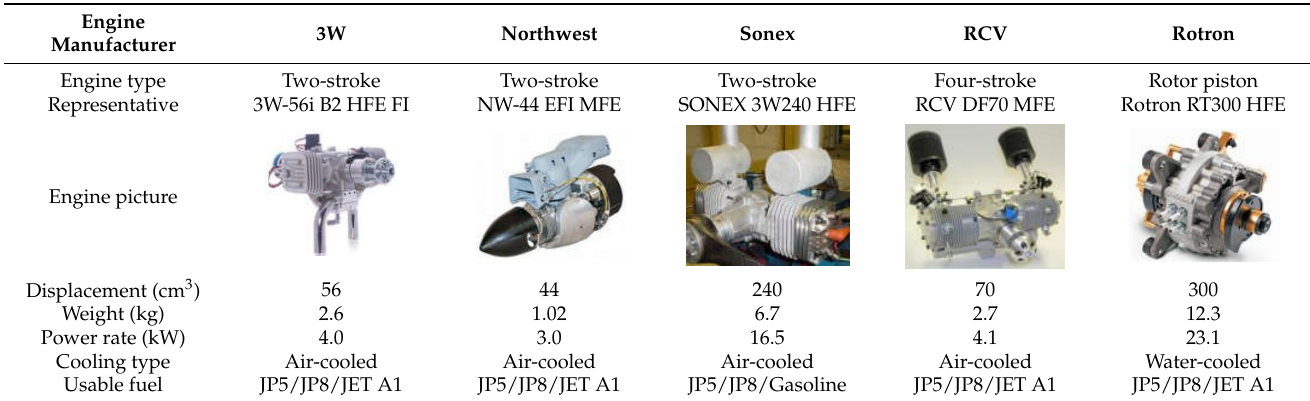
Table 1. Heavy-oil, ignition, piston engine with an inlet injection mode.